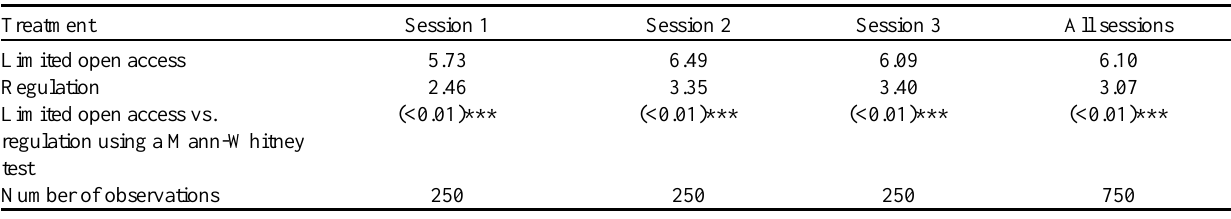
Table 3 . Average level of extractions under limited open access and regulation